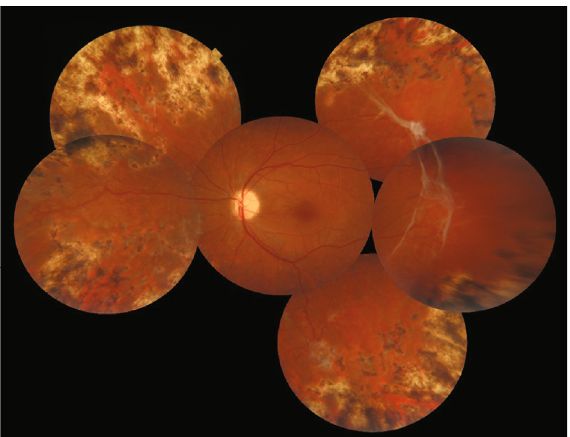
Figure 4: Montage fundus photograph of the left eye 6 months later revealed that vitreous and preretinal hemorrhages cleared, sea fan neovascularization partially regressed, and fi brotic membrane extended in the temporal midperipheral